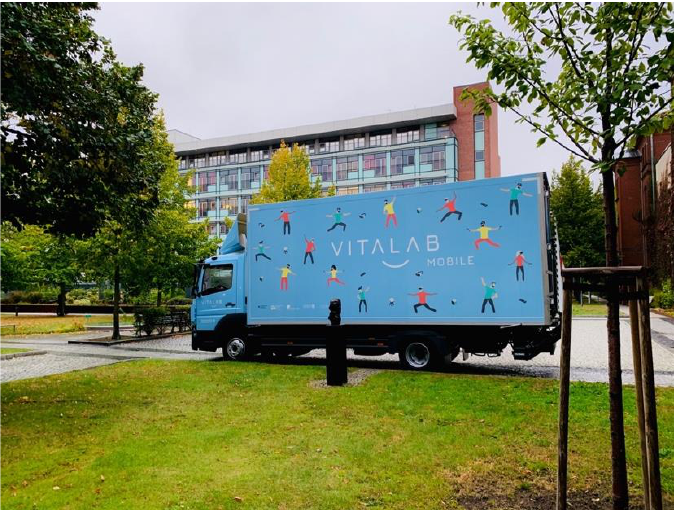
Figure 1. The study took place in the VITALab.Mobile, a mobile VR/AR laboratory for case and field studies.